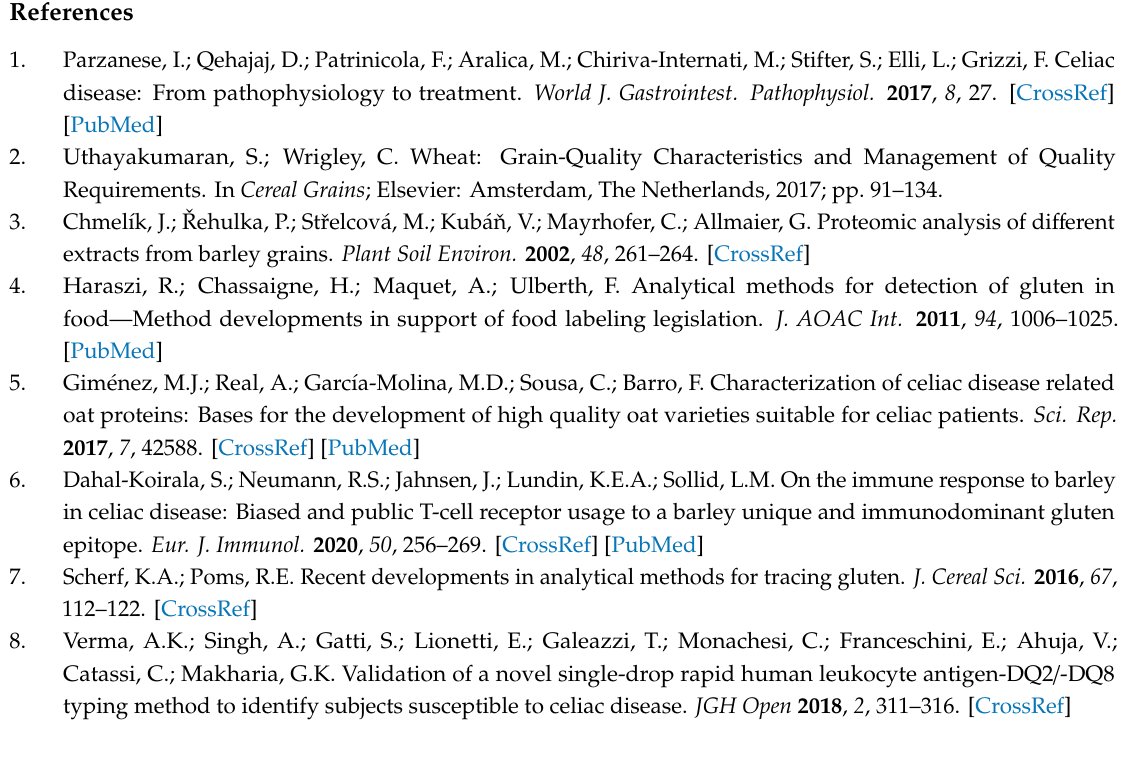
Supplementary Materials: The following are available online, Table S1: Characteristics of Products, Table S2: Mapping Data, Table S3: Antibody Characteristics, Table S4: Correlation